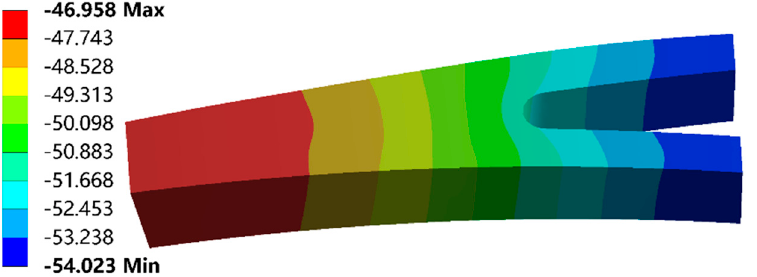
Figure 17. Vertical deformation of bifurcated segment of arch rib under constant load (unit: mm).